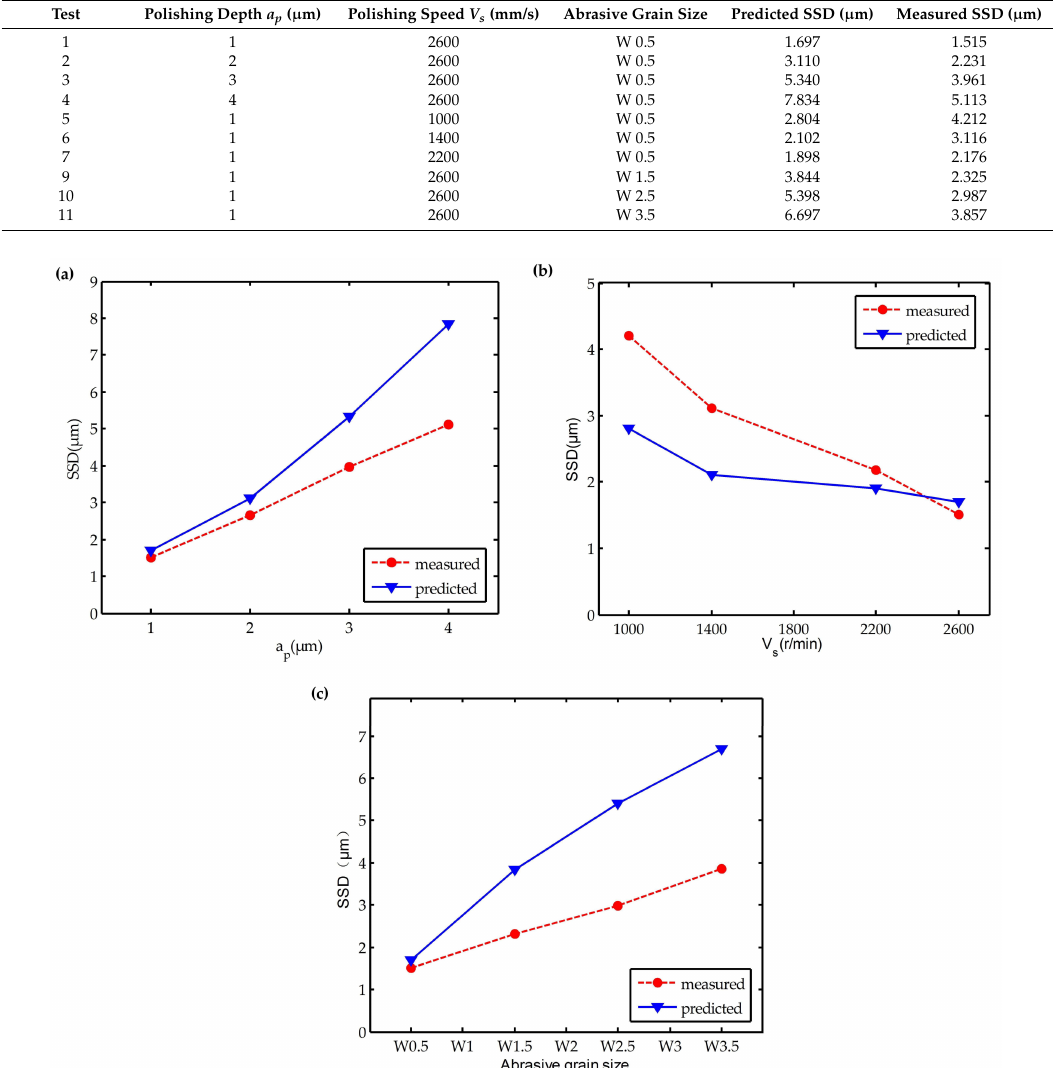
Figure 12. Dependence of SSD depth on polishing parameters: ( a ) polishing depth a p ; ( b ) spindle speed V s ; ( c ) abrasive grain